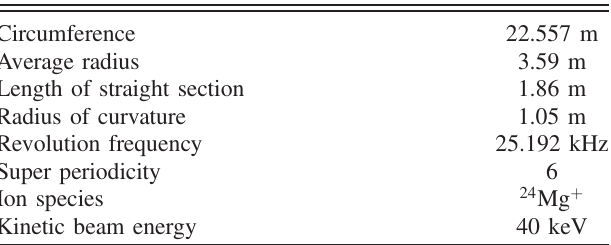
TABLE I. Main parameter of S-LSR.